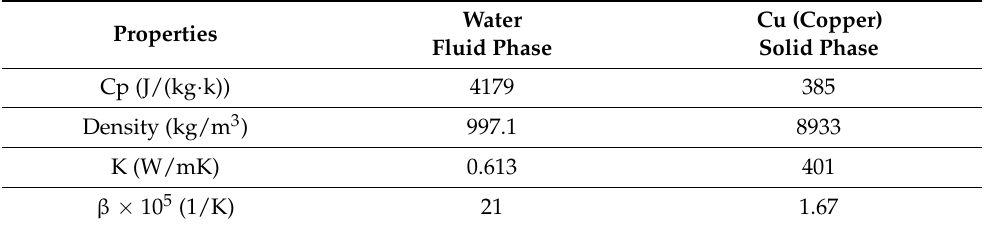
Table 1. Thermo-physical (TH) properties of BF (base fluid) and copper of nanoparticles